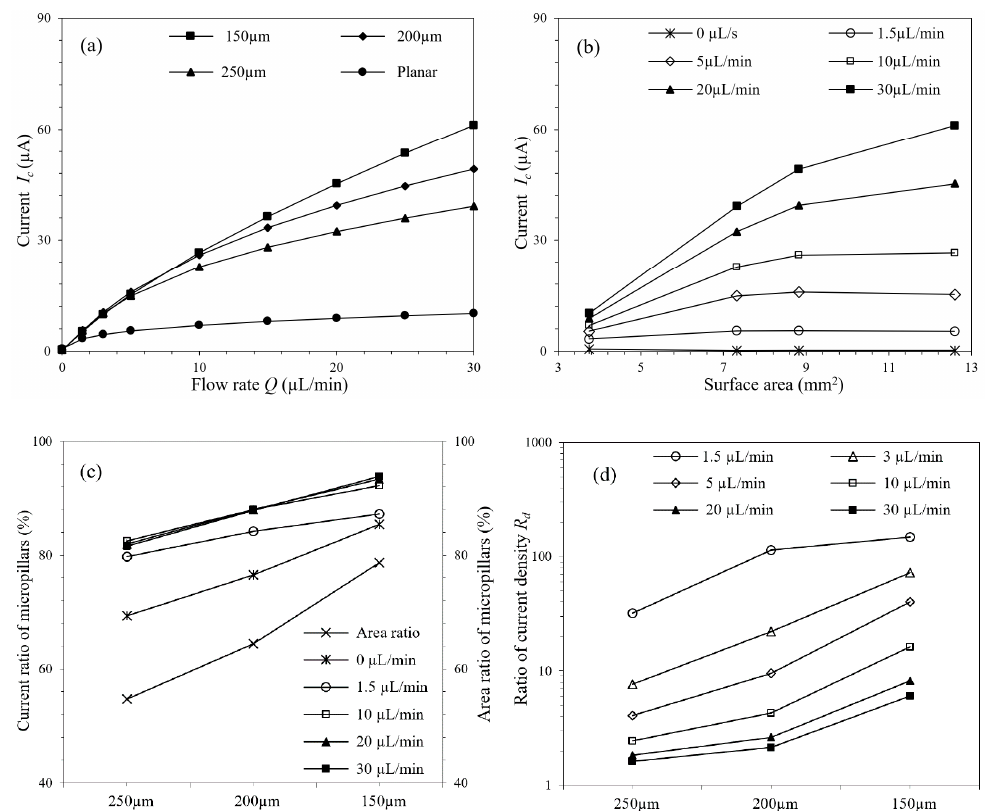
Figure 5. ( a ) Current responses of μ AEs with various spacings at different flow rates and spacings; ( b ) Current responses of μ AEs with various surface area at different flow rates; ( c ) Current and area ratios of μ AEs with various spacings at different flow rates; ( d ) Ratios of the current density between the first and last row of micropillars.